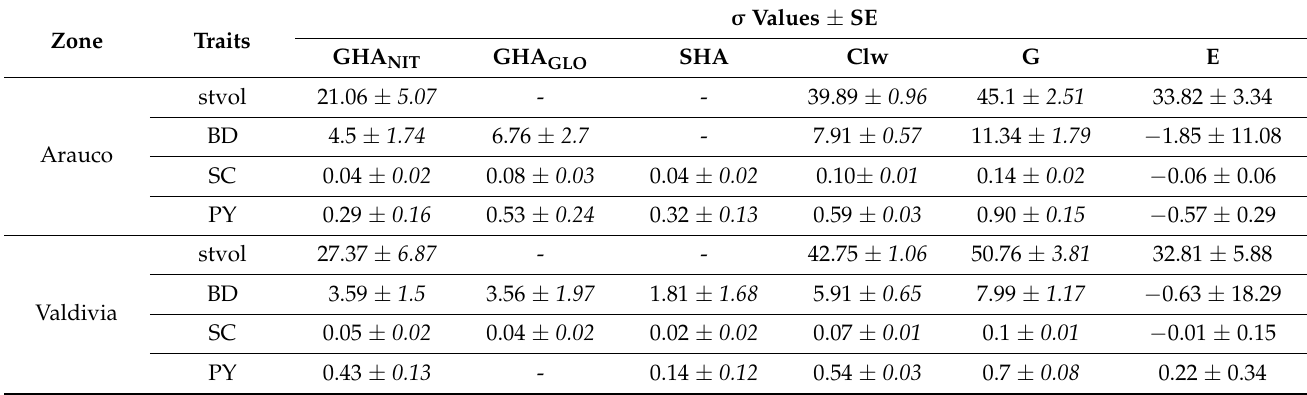
Table 5. Variance component estimates from combined-site analysis for standardized volume (stVol), Basic Density (BD), Specific Consumption (SC), and Pulp Yield (PY) in Arauco and Valdivia zone with their respective SE. GHA NIT or GHA GLO is the General Hybridizing Ability variance due to E. nitens female or E. globulus male. SHA is the Specific Hybridizing Ability variance. Clw is the clonal variance within family. G is the total genetic variance. E is the variance estimate of epistasis. All these genetic variances are expressed in sigma values ( σ